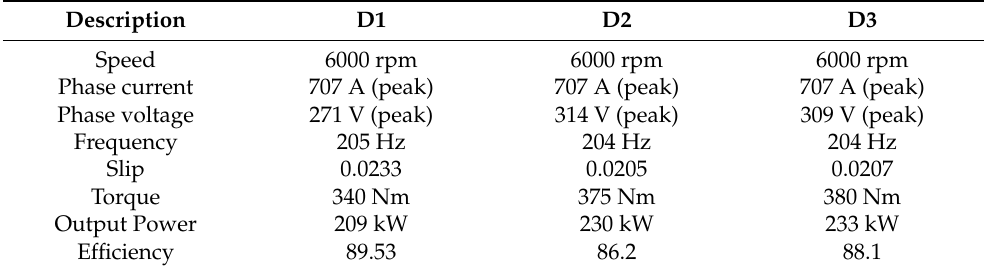
Table 6. Performances at the peak-power working point for the three proposed designs.